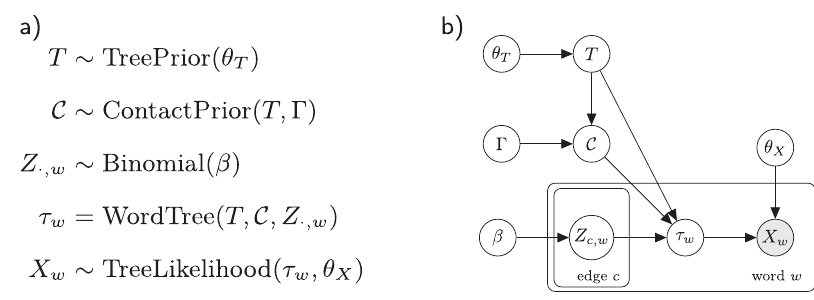
Fig. 2 The contacTrees model. The de fi nition of the generative process ( a ) and its graphical representation ( b